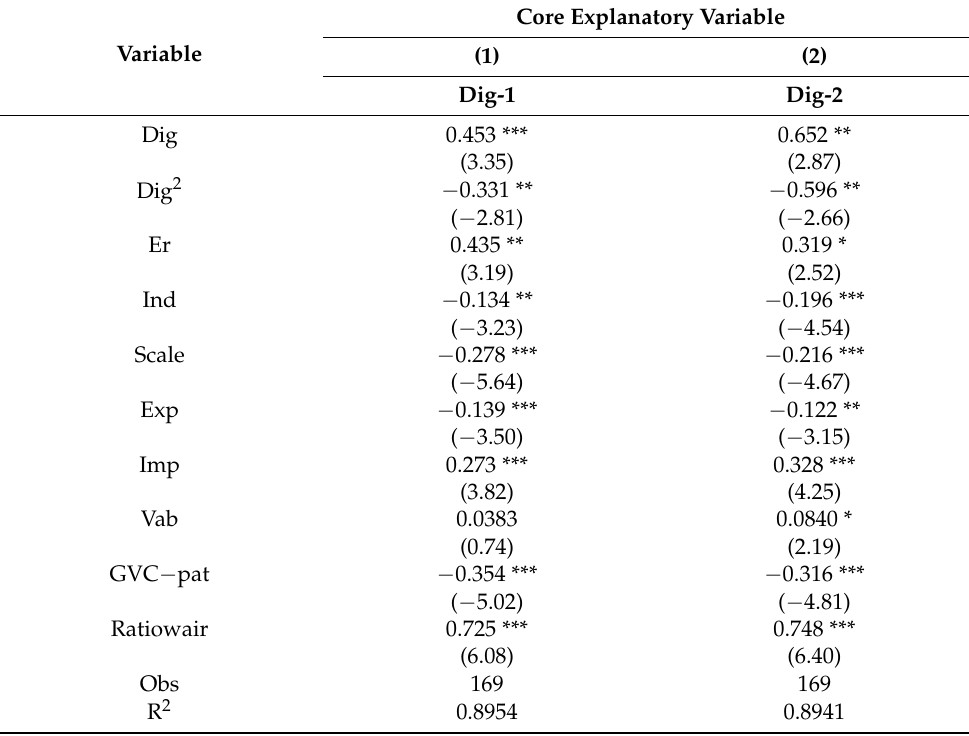
Table 4. Estimation